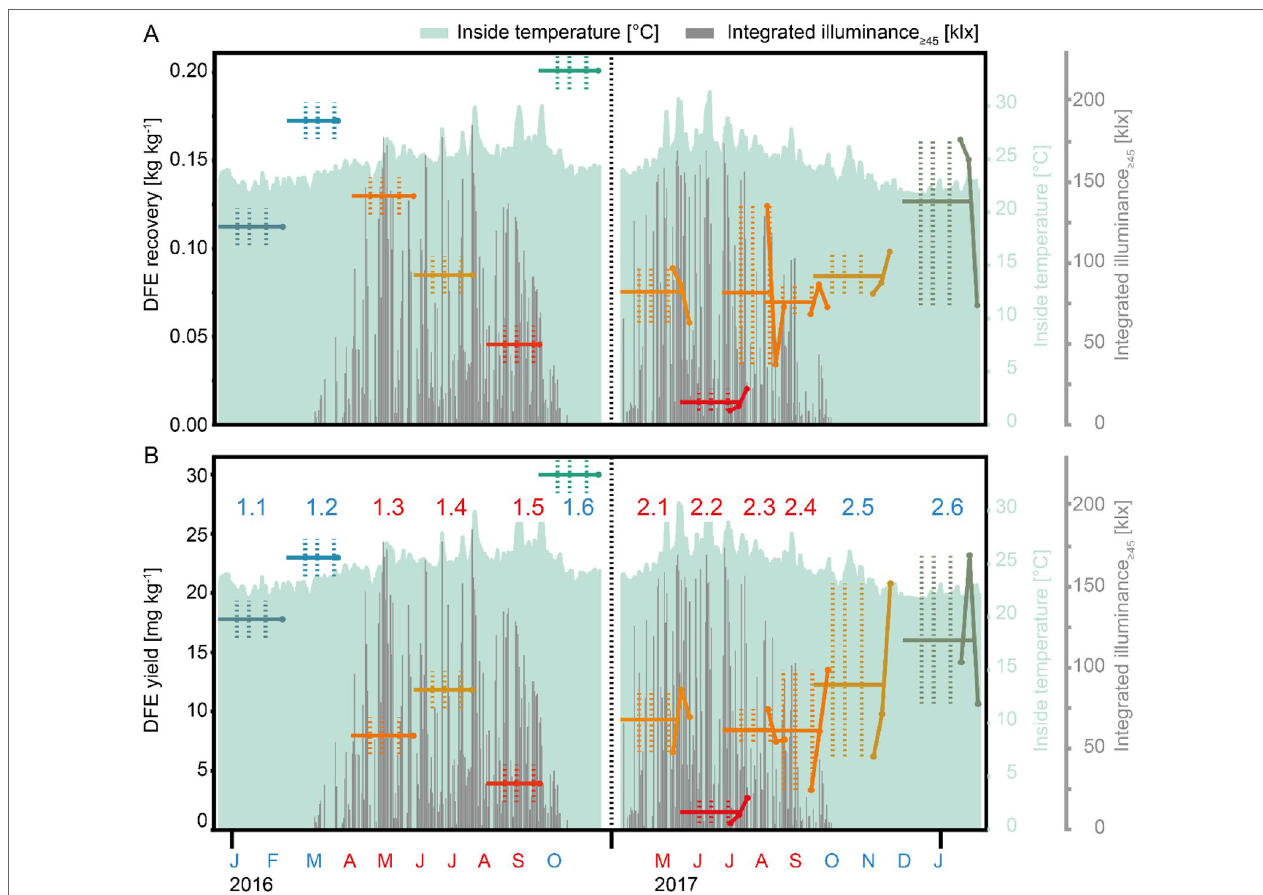
FIGURE 2 | DFE recovery and yield over the changing seasons. (A) DFE recovery following IMAC purification. The recovery is defined as the ratio of DFE in the elution fraction (after purification) and the DFE amount in the load (before purification). (B) Overall DFE yield after purification per kilogram of fresh plant biomass. Labels in B (numbers) indicate the allocation to summer (red) or winter (blue) batches, and the black vertical dotted lines separate the first (left) and second (right) set of batches. Horizontal lines indicate the average batch recovery (A) and yield (B) calculated based on all harvests of one batch, whereas colored point-scatter plots correspond to the individual harvest-specific recovery (A) and yield (B) values in the second batch set. Vertical colored dotted lines mark the transitions between the growth phases in each batch (left line = germination to sprouting, middle line = sprouting to growth, and right line = growth to maturation) analyzed in Table 2 . Light green areas mark the inside temperature in a greenhouse whereas gray columns correspond to the integrated